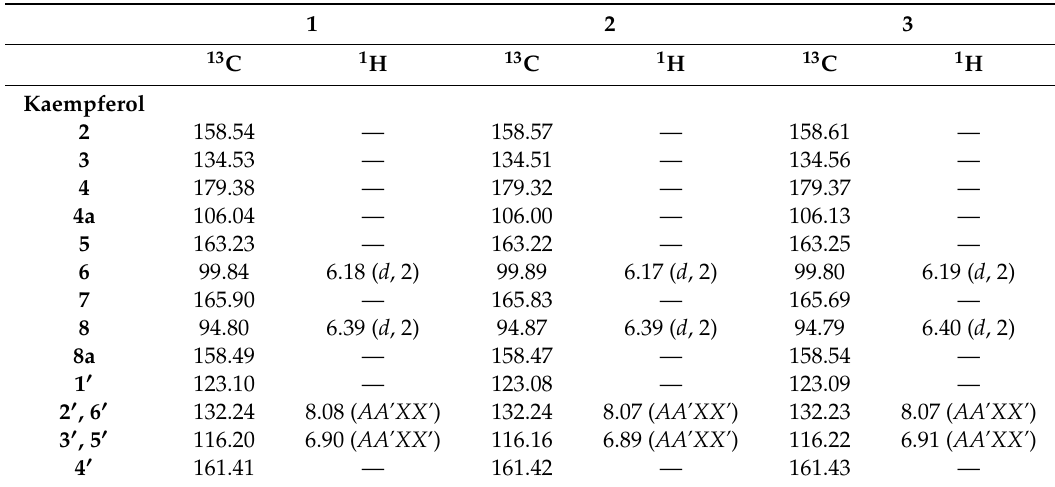
Figure 3. Kaempferol- O-tri- glycosides 1 , 2 and 3 . Table 1. 13 C- and 1 H-NMR data ( J in Hz) for the aglycone moiety of kaempferol glycosides 1 , 2 and 3 in CD 3 OD.